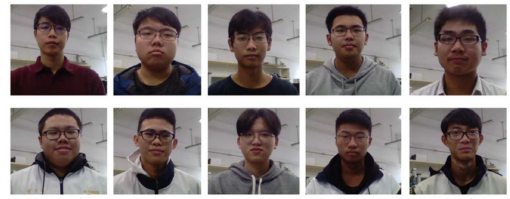
Figure 14. Collected images of ten targets.